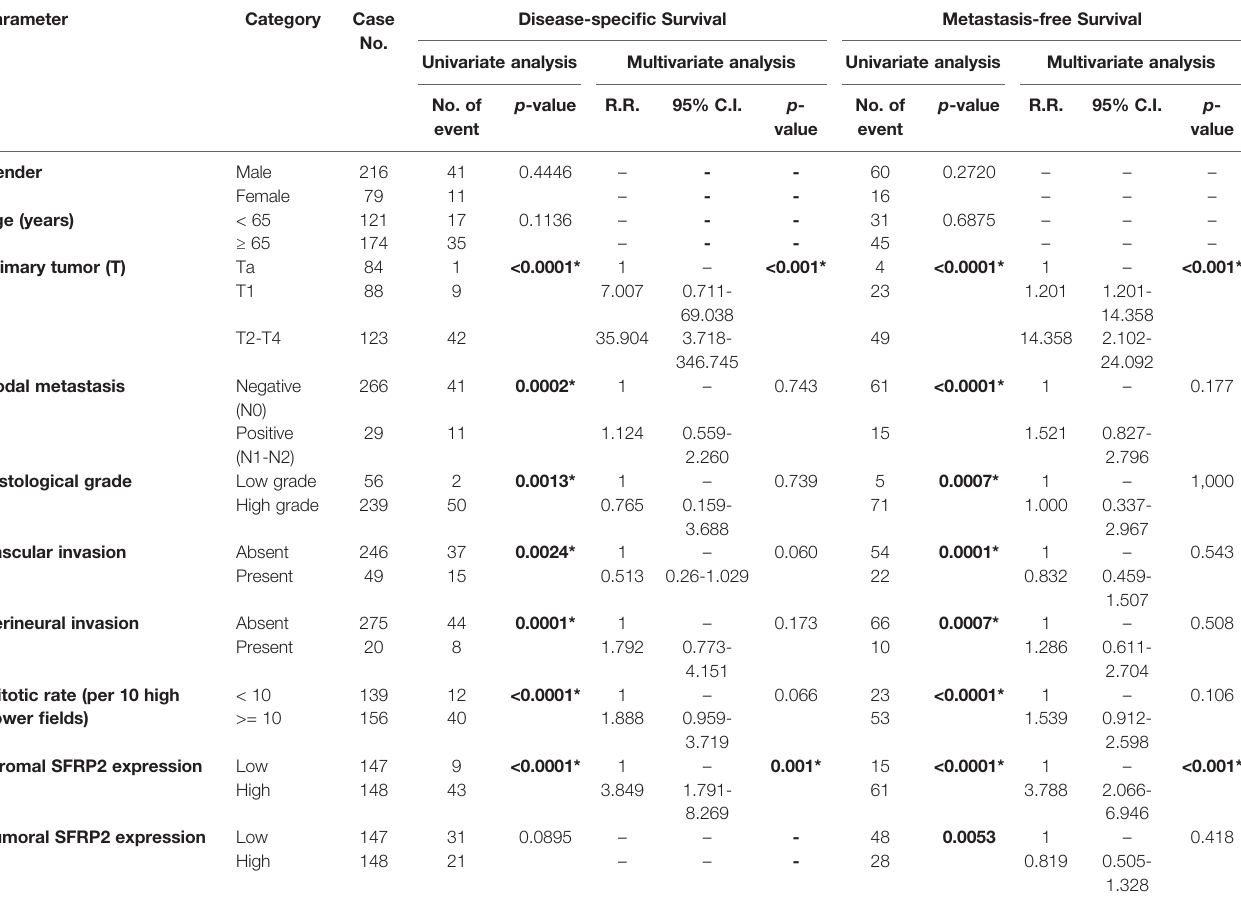
TABLE 5 | Univariate log-rank and multivariate analyses for disease-speci fi c and metastasis-free survivals in urinary bladder urothelial carcinoma.